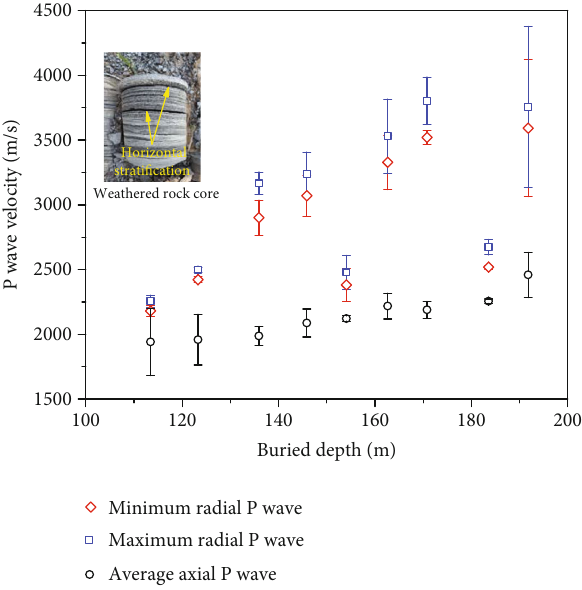
Figure 7: Variation of P wave velocity with an increase of buried